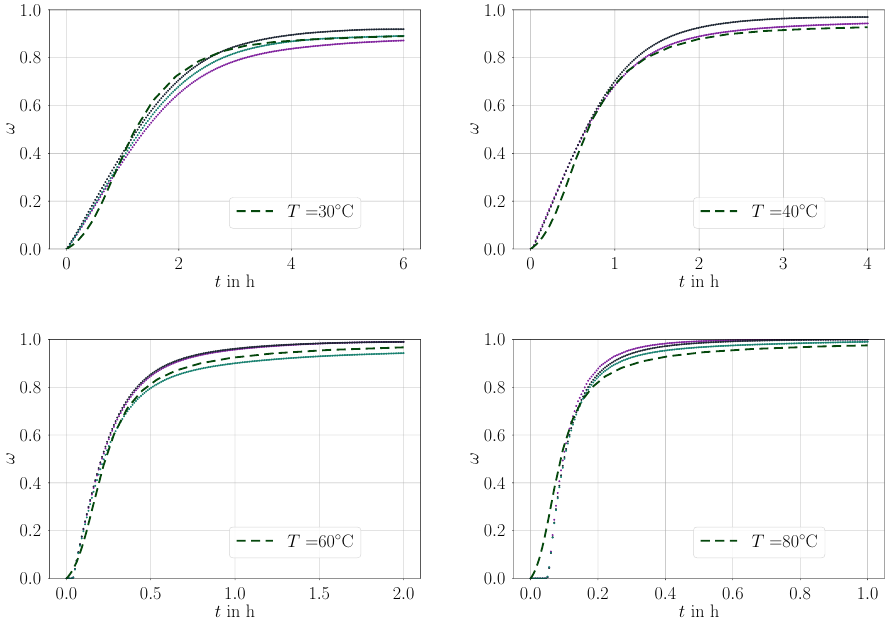
Figure 3. Comparison of the parameter fit (dashed line) with all experimental values (dots) used for the fit, material: material